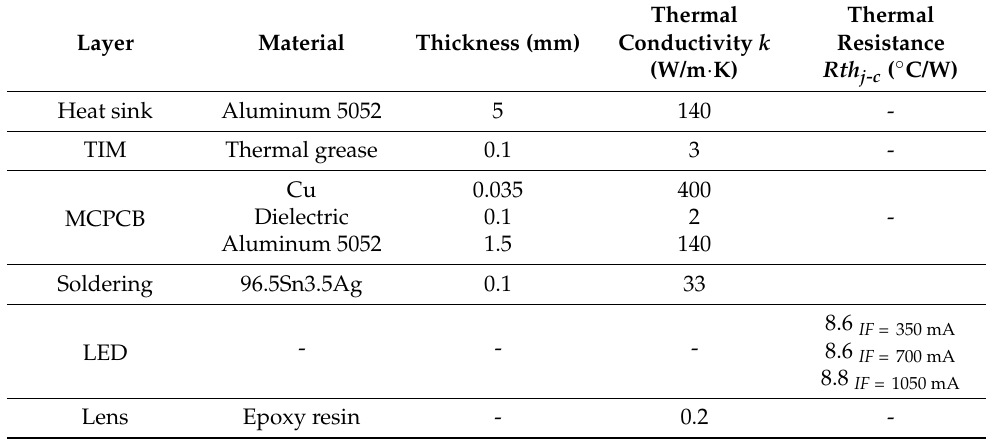
Figure 4. Structure of an example LED panel (2 × 6 LEDs). Table 1. LED panel — materials and their thermal parameters [35].